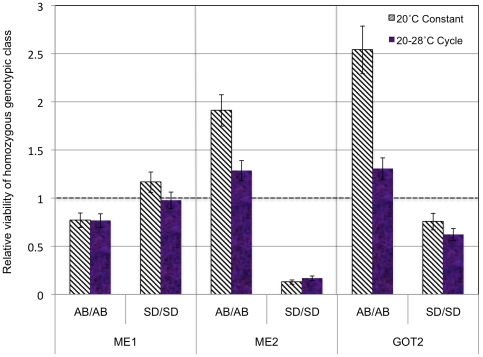
Relative viability of the ME1, ME2, and GOT2 markers in ABf x SDm cross.The results are given for F2 adults hybrids for each of the three genes under two different sets of environmental conditions from crosses of the AB and SD populations of the copepod T. californicus. The 20° constant and 28° cycling crosses are indicated with hatched and solid bars respectively. The relative viability of the two homozygous genotypic classes in comparison to the heterozygous genotypic class is given with standard deviations indicated by error bars. A value of one would indicate that the homozygous class had the expected number relative to the heterozygous class, i.e. a 1∶2 ratio, while higher or lower values would represent more or fewer than expected respectively. The homozygous genotypic class is indicated by AB/AB or SD/SD. Although there were significant differences in genotypic ratios between males and females, these stemmed from differences in the magnitude and not direction of deviations (with females having larger deviations). Full numerical results are available in Table S2.